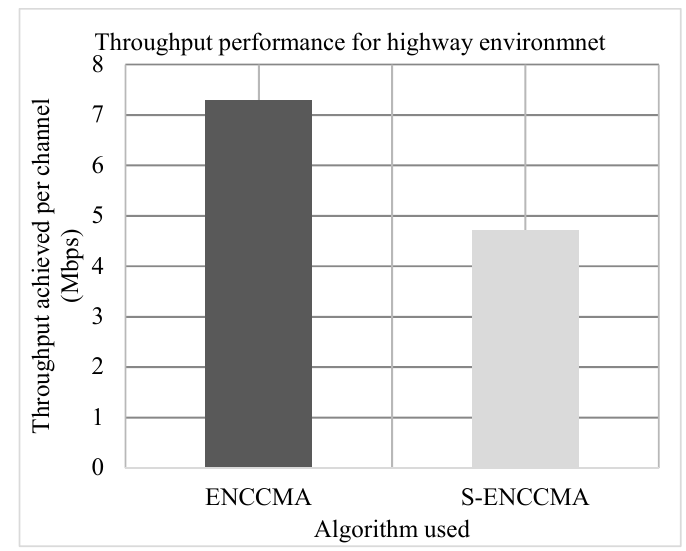
Figure 3. City environment throughput performance for varied vehicles.